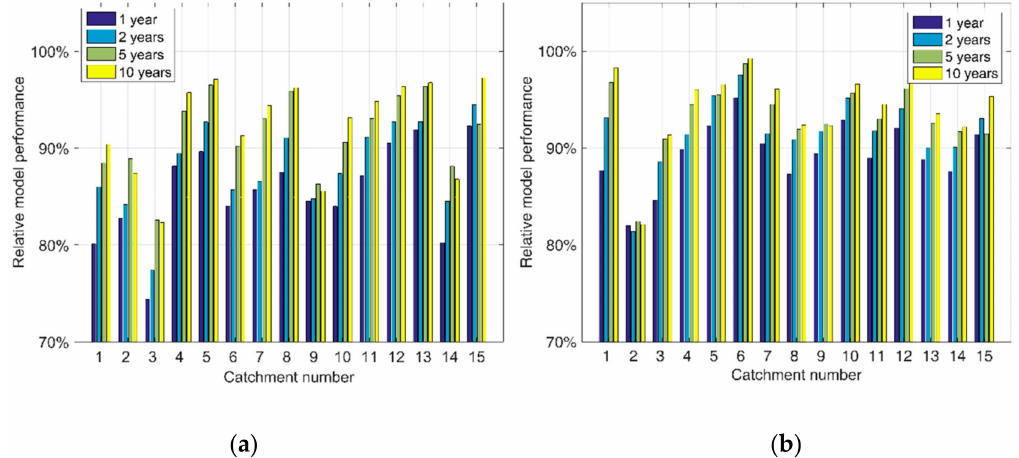
Figure 7. Relative NSBs by transfer parameters that calibrated based on di ff erent lengths of data. ( a ) 1970–1979; ( b )